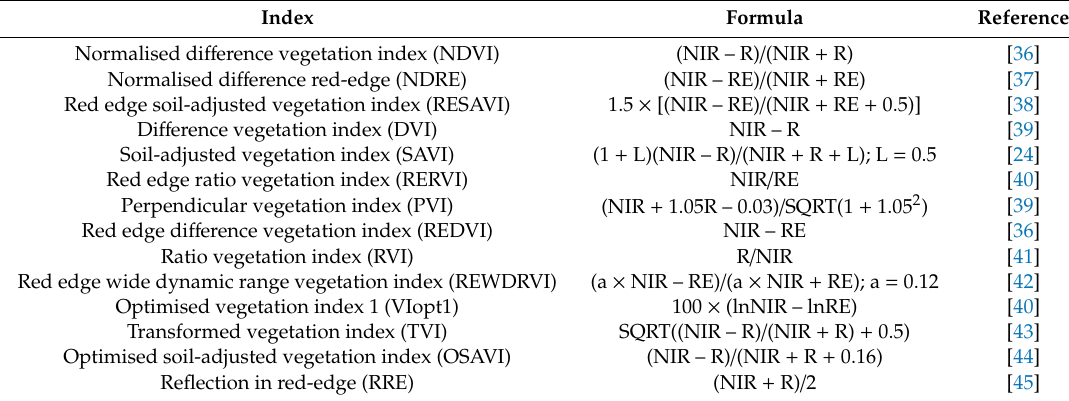
Figure 2. The RapidSCAN CS-45 canopy sensor. Table 2. Vegetation indices used for the RapidSCAN CS-45 sensor.